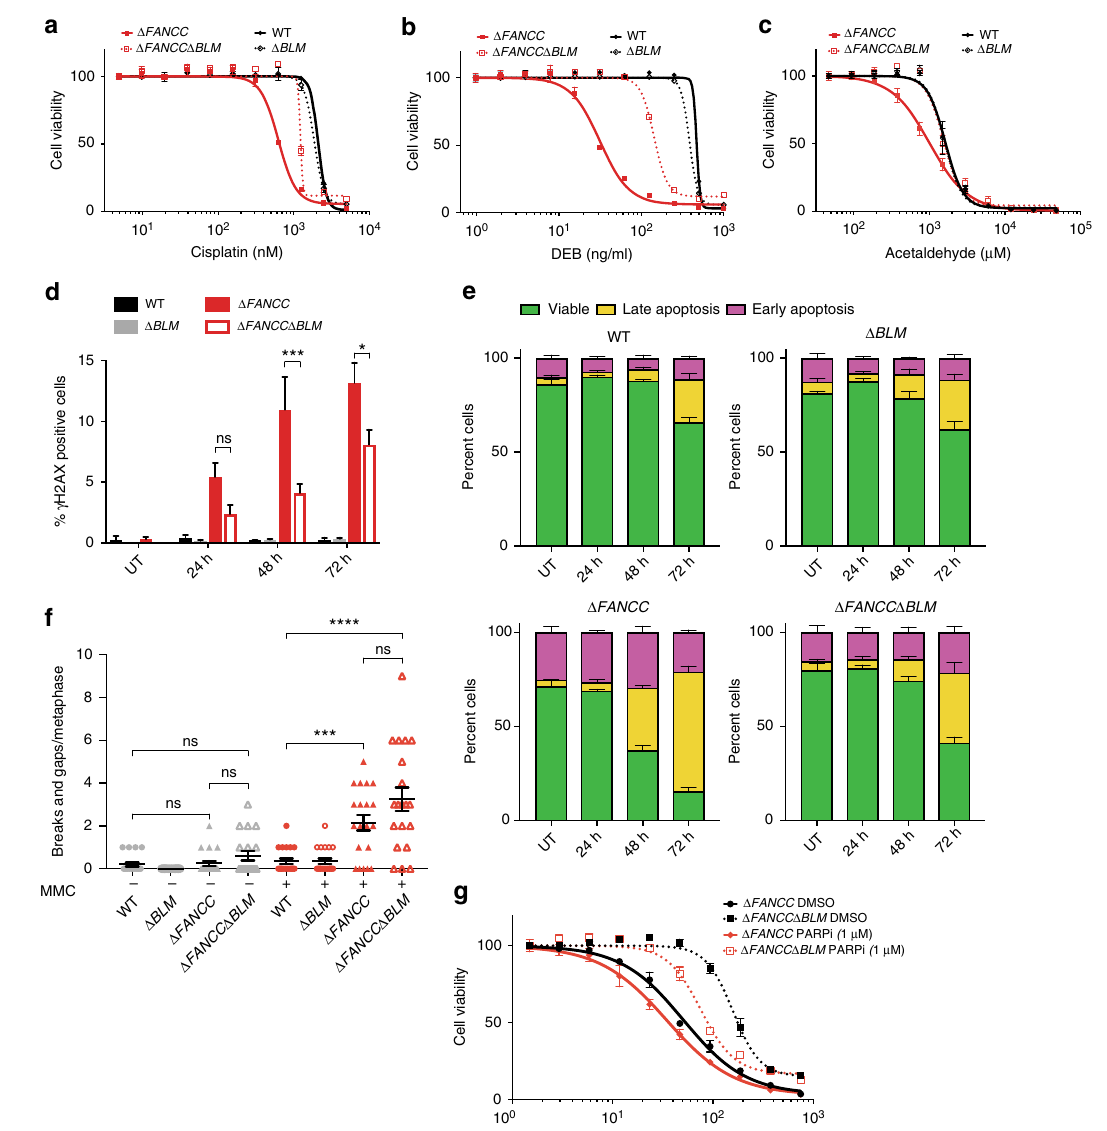
Fig. 2 Loss of the BLM complex in FANCC de fi cient cells alleviates DNA damage and apoptosis induced by ICLs. a – c Treatment of indicated cell lines with cisplatin, diepoxybutane (DEB) and acetaldehyde for 4 days. Survival assessed by CellTiter-Glo. d Indicated cells were left untreated (UT) or treated with MMC for 24, 48, or 72 h, stained for γ H2AX and analyzed by High Content Imaging. p -values determined by two-way ANOVA. e Cells were either left untreated or treated with MMC for 24, 48, and 72 h, then apoptosis was measurement using propidium iodide (PE) Annexin V staining, followed by fl ow cytometry analysis. f Quanti fi cation of chromosome breaks and gaps of 40 cells per cell line treated with MMC for 24 h followed by analysis of metaphase spreads. p -value determined by Mann – Whitney U test. g Survival of indicated cells treated with either the PARP inhibitor olaparib (PARPi) or DMSO for 4 h, followed by MMC exposure for 4 days. Survival assessed by CellTiter-Glo. For all panels, means and S.E.M. of biological triplicates are plotted. ns = p > 0.05; * = p < 0.05; ** = p < 0.01; *** = p < 0.001; **** = p <